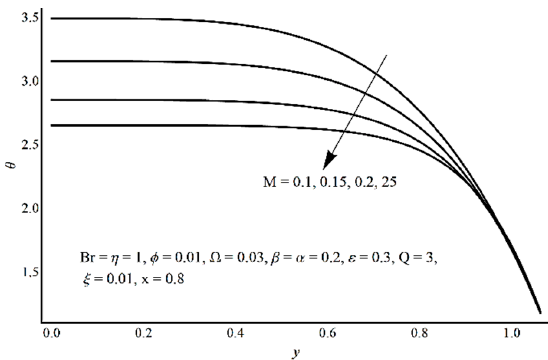
Figure 16. The temperature profile against various values of the Hartmann number M.